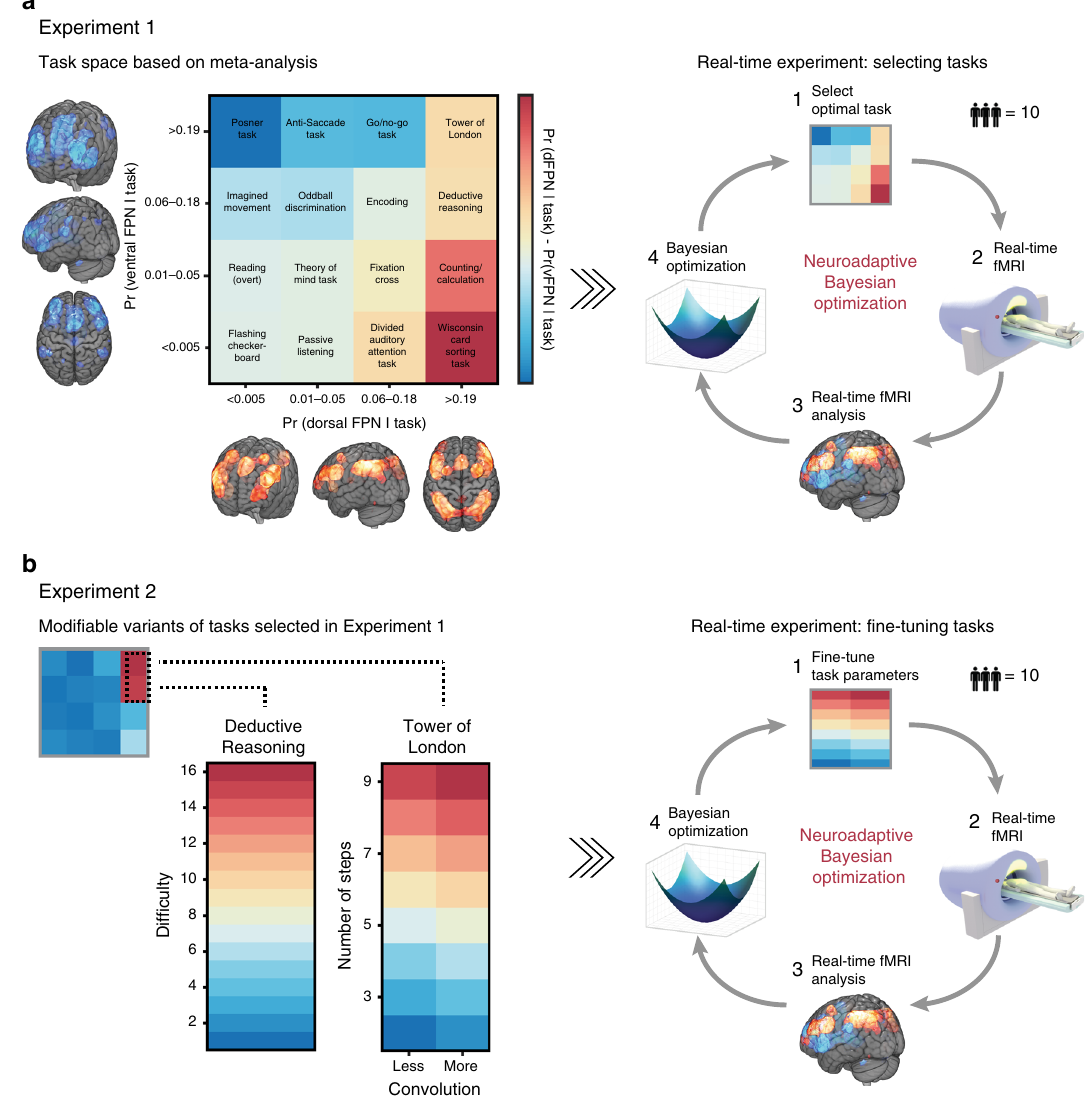
Fig. 1 Overview of methodology. a In Experiment 1, a 2D-task space was designed with each dimension corresponding to the probability of 16 tasks recruiting the dFPN or vFPN according to a previous meta-analysis 26 . Color-coding indicates the hypothesized dissociation (based on this meta-analysis) between the two FPNs: red indicates tasks to be optimal for the contrast dFPN > vFPN (i.e., Wisconsin Card Sorting and Counting/Calculation tasks), while blue indicates tasks to be optimal for the reverse contrast vFPN > dFPN (i.e., Posner, Anti-Aaccade and Go/No-go tasks). This task space was then searched in real-time by the neuroadaptive Bayesian optimization to fi nd optimal tasks that dissociate the dFPN from the vFPN. b In Experiment 2, task parameters of optimal tasks from Experiment 2 were fi ne-tuned. For the Deductive Reasoning task, the optimization algorithm searched across 1D-space with 16 × 1 dif fi culty levels. For the Tower of London task, the optimization algorithm searched across 2D-space with 8 (number of steps) x 2 (convolution) parameters. In Experiment 3 (not shown), the same 2D-task space as in Experiment 1 was searched through by the optimization algorithm with the aim of fi nding task that maximally dissociate the dFPN and vFPN from three other FPNs (for details see main